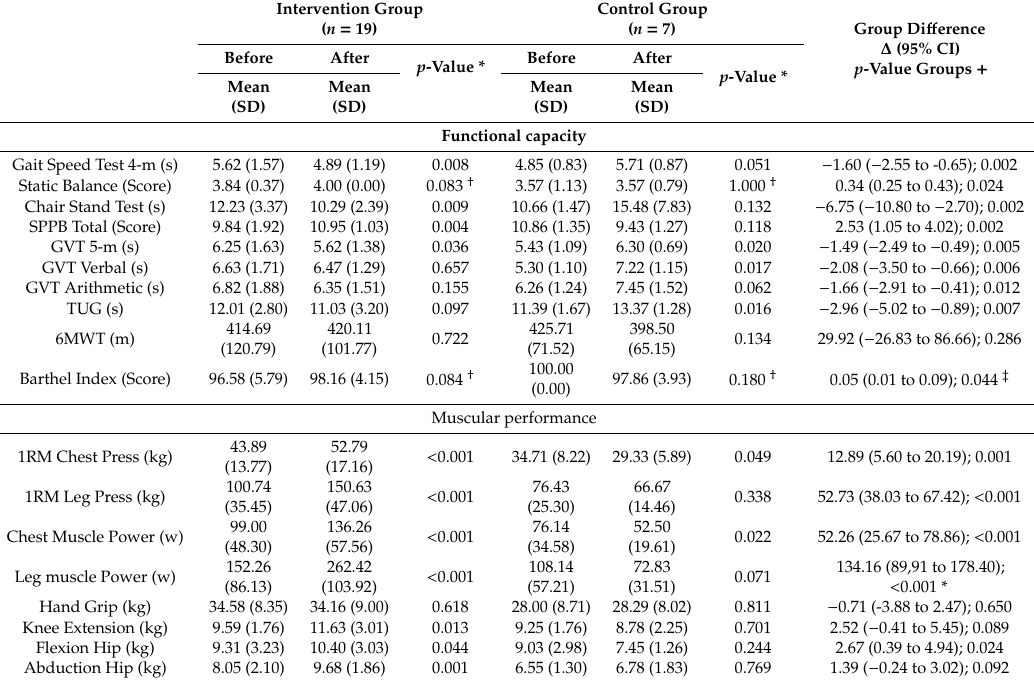
Table 3. Results of physical functioning outcomes by